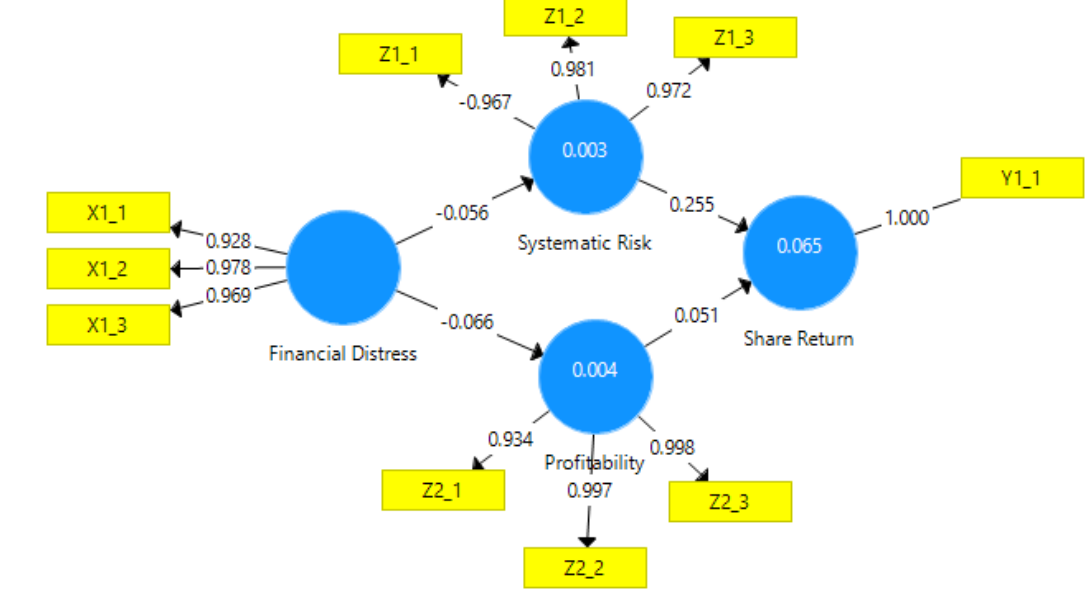
Fig. 3. Outer Model Calculation Results After Dropping